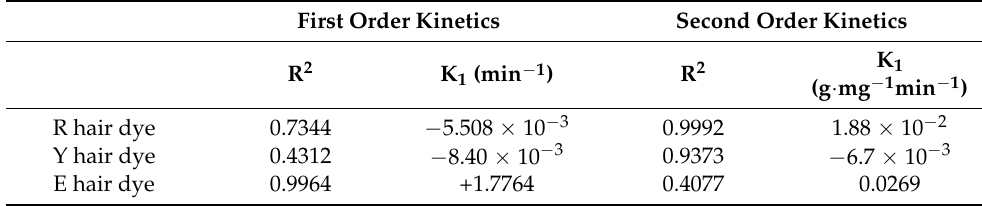
Figure 10. Kinetic studies of the adsorption of ebony hair dye onto COZ, [dosage = 0.07 g R, 0.06 g Y, & 0.05 E, C i = 50 mg·L − 1 , pH = 7.0, contact time = 120 mint. for R and E, 150 mint. for Y, T = 25 ± 1 °C, speed = 150 rpm]. Table 2. Kinetics